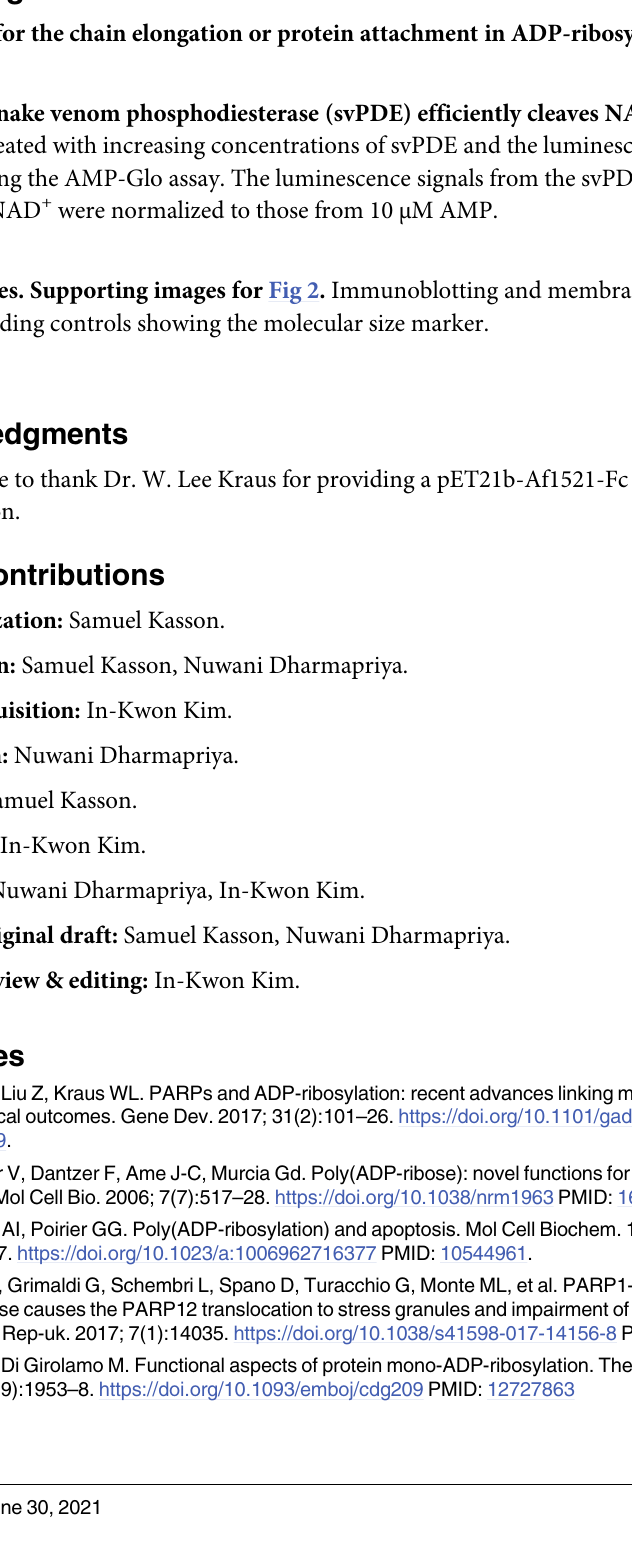
S1 Fig. Sites for the chain elongation or protein attachment in ADP-ribosylations. (PDF) S2 Fig. The snake venom phosphodiesterase (svPDE) efficiently cleaves NAD + . 10 μ M NAD + was treated with increasing concentrations of svPDE and the luminescence signals were measured using the AMP-Glo assay. The luminescence signals from the svPDE-mediated digestion of NAD + were normalized to those from 10 μ M AMP. S1 Raw images. Supporting images for Fig 2. Immunoblotting and membrane staining with respective loading controls showing the molecular size